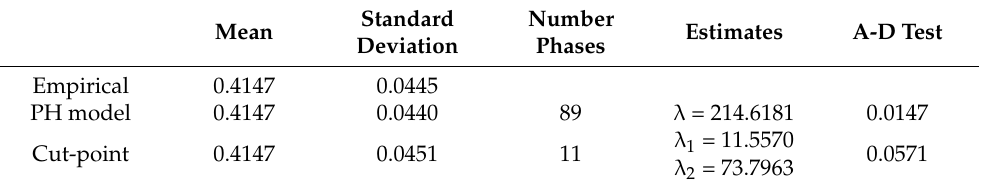
Table 3. Summary for the PH and one cut-point adjustment for the set voltage.